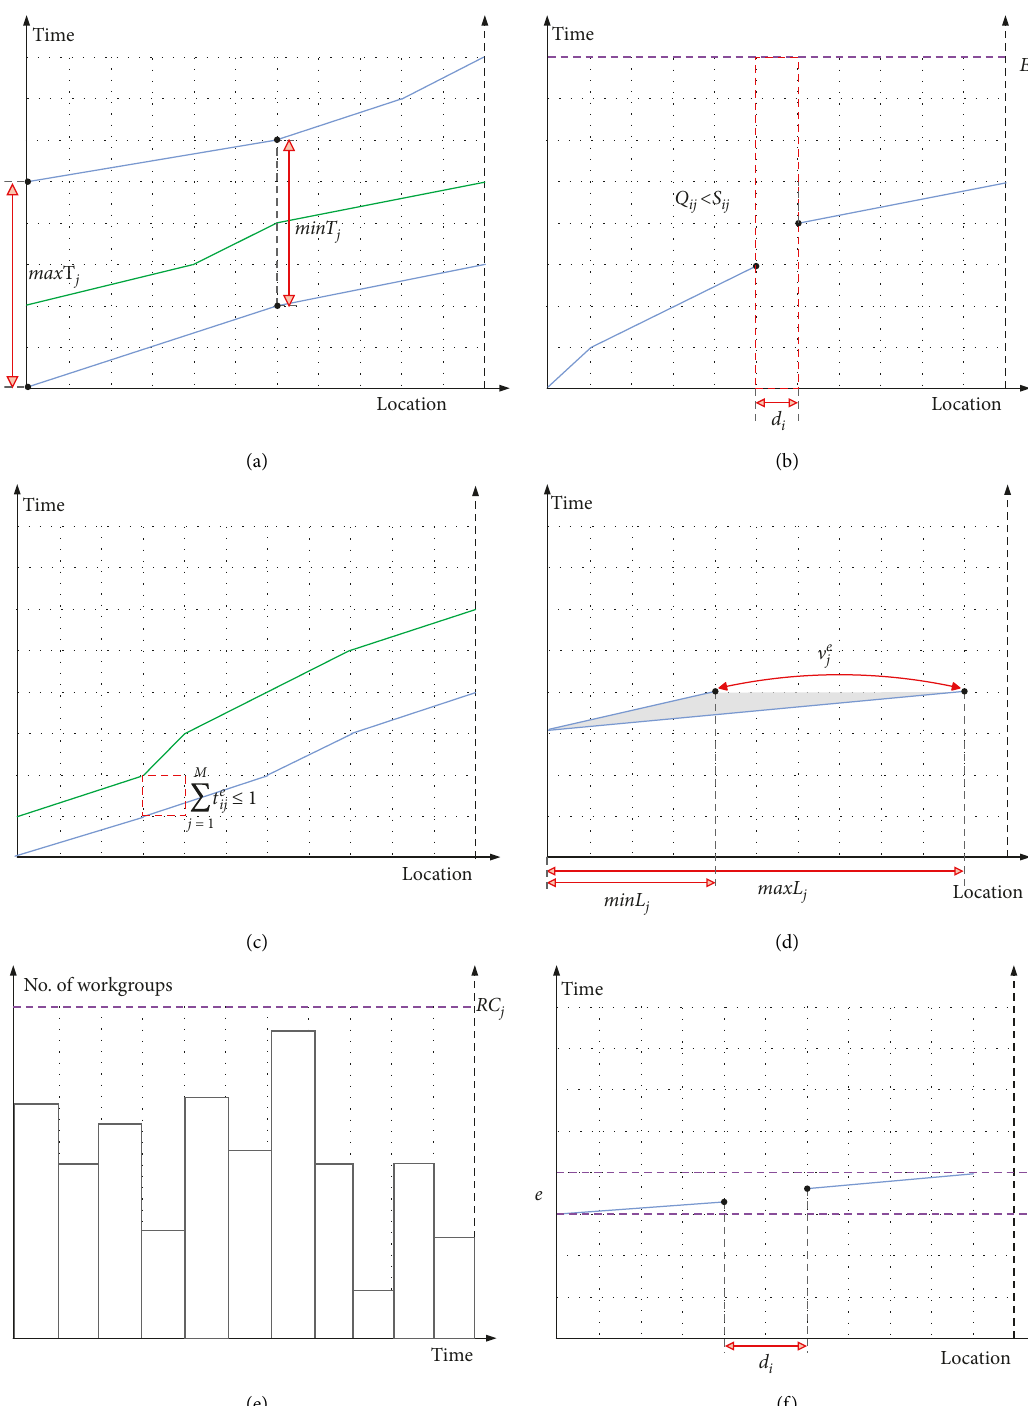
Figure 5: Map of time-location grids based on various constraints of track inspection activities. (a) Time constraint between activities. (b) Fixed duration constraint. (c) Spatial constraint between activities. (d) Rate constraint of activities. (e) Resource constraint. (f) Continuity